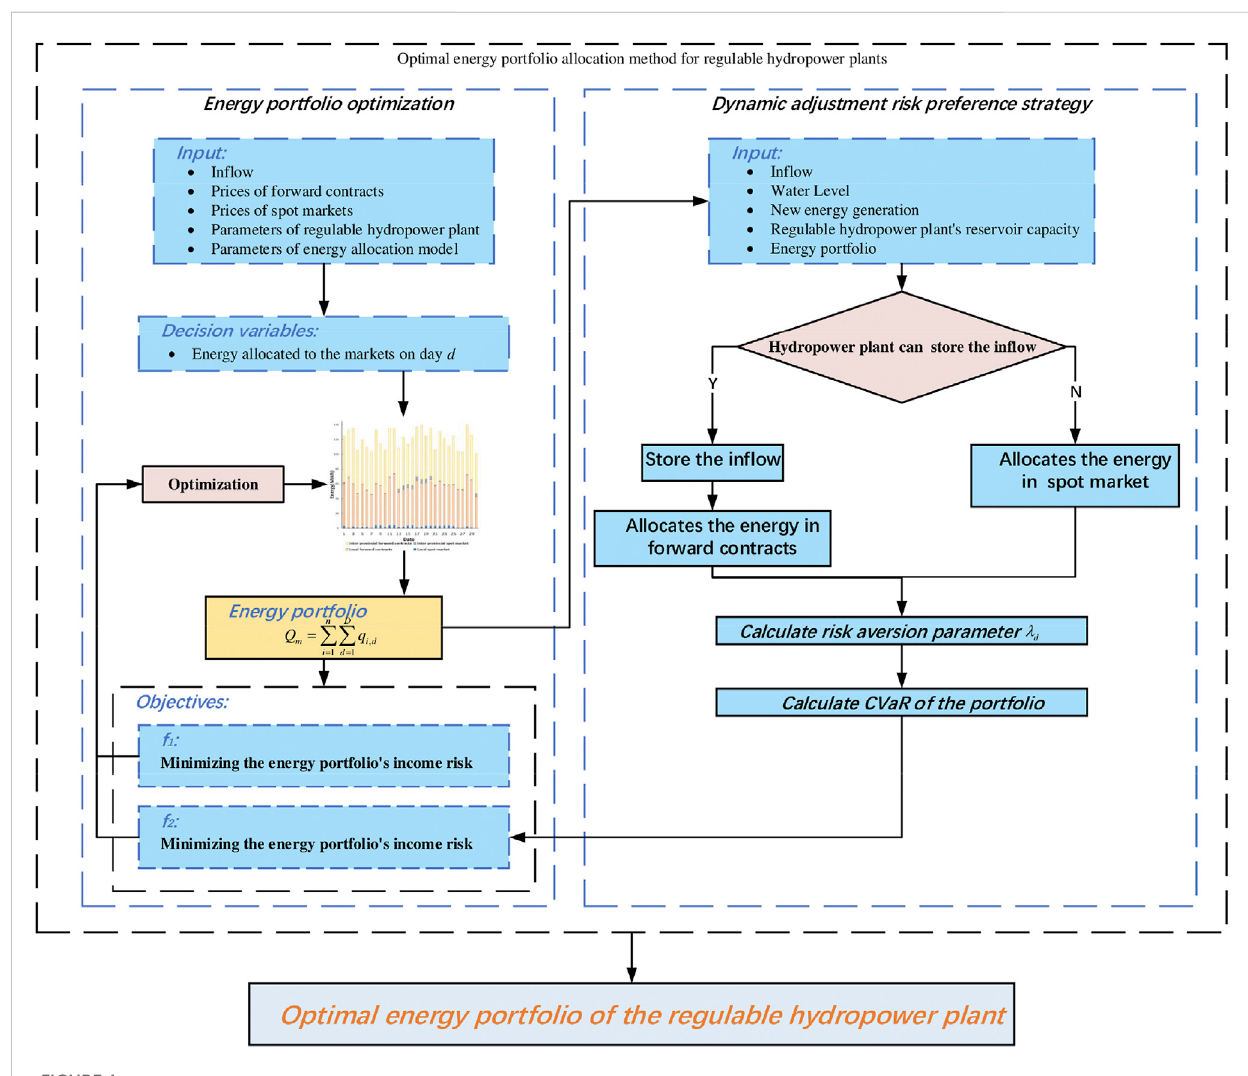
FIGURE 1 Flowchart of the energy portfolio allocation method optimization